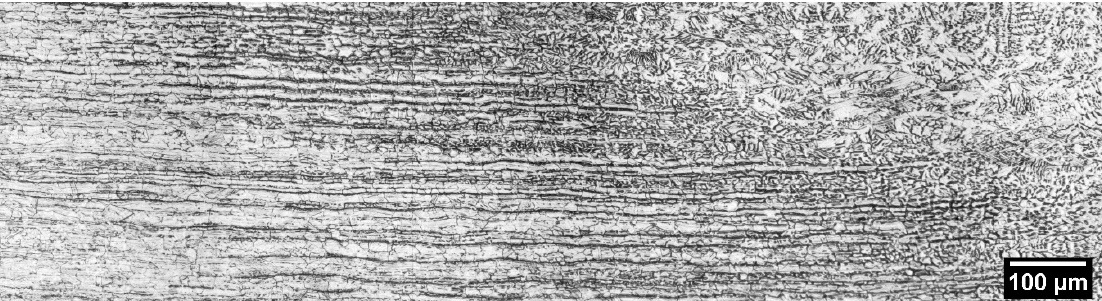
Figure 4. Transversal micrography at the weld bead (right)/HAZ (left) interface after 17% cold rolling.